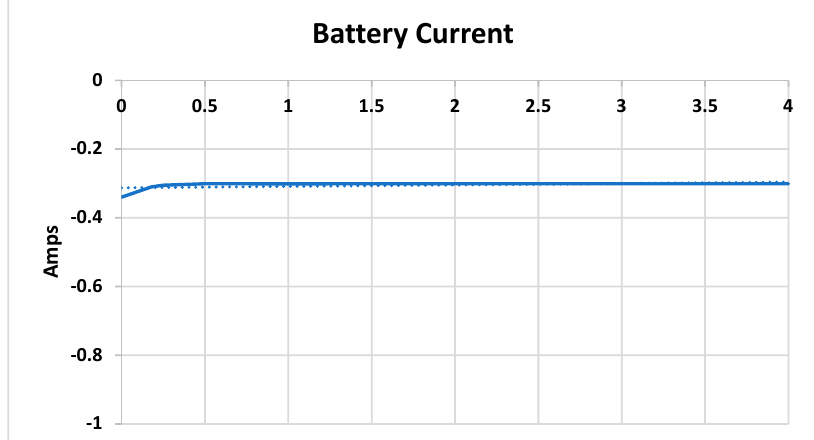
Figure 18. Charging/Current In.